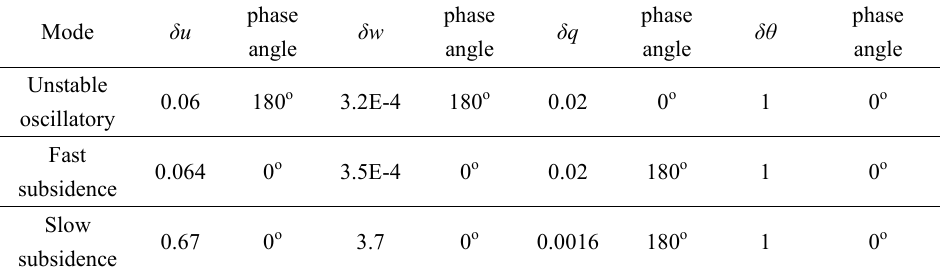
Table 3 Magnitudes and phase angles of each of three